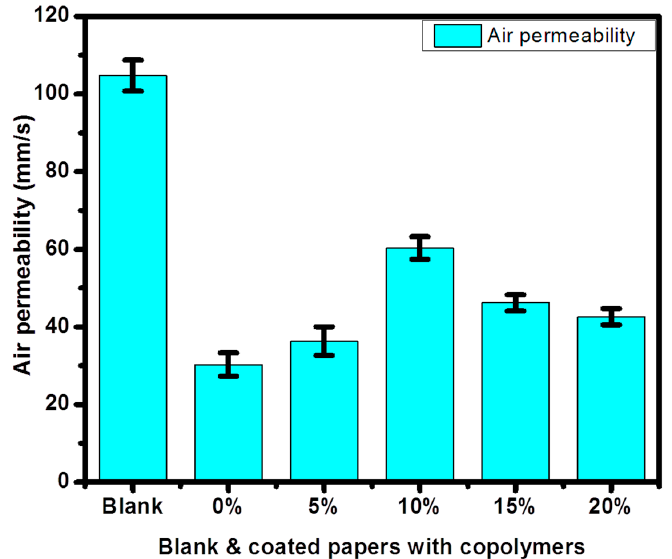
Figure 6. The air permeability of the blank paper and paper coated with PVAc and its copolymers containing different fractions of lignin.